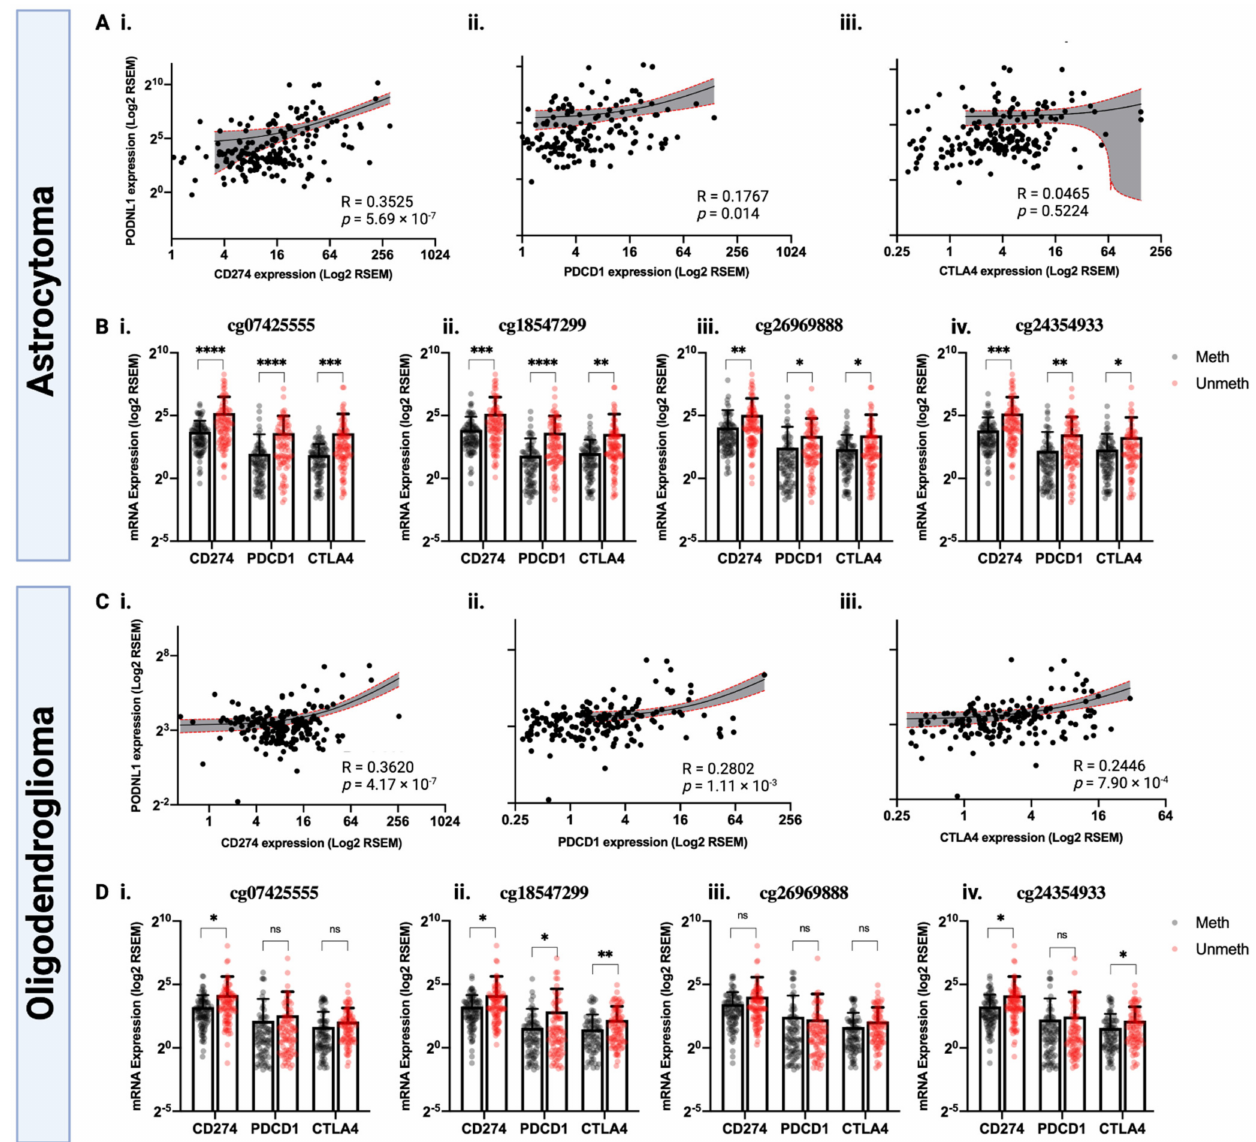
Figure 7. Association between PODNL1 expression/specific PODNL1 CpG methylations and immunotherapeutic targets— PD-L1 ( CD274 ), PD-1 ( PDCD1 ) and CTLA4 , in TCGA astrocytoma ( Ai – Aiii ) and ( Bi – Biv ) and in TCGA oligodendroglioma ( Ci – Ciii ) and ( Di – Div ). R = Spearman’s rho correlation coefficient. Methylation groups of high (meth) and low (unmeth) were determined with a median beta-value cutoffs for each CpG. A p -value of less than 0.05 was considered statistically significant. **** p < 0.0001, *** p < 0.001, ** p < 0.01, * p < 0.05, and ns = not